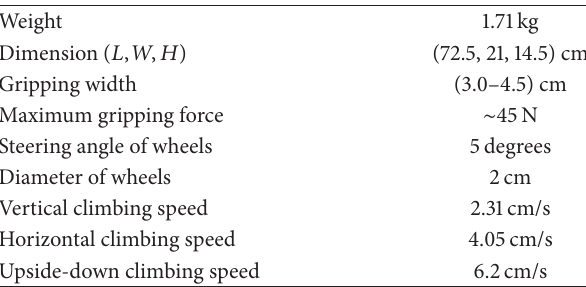
Table 1: The specifications of frambot.